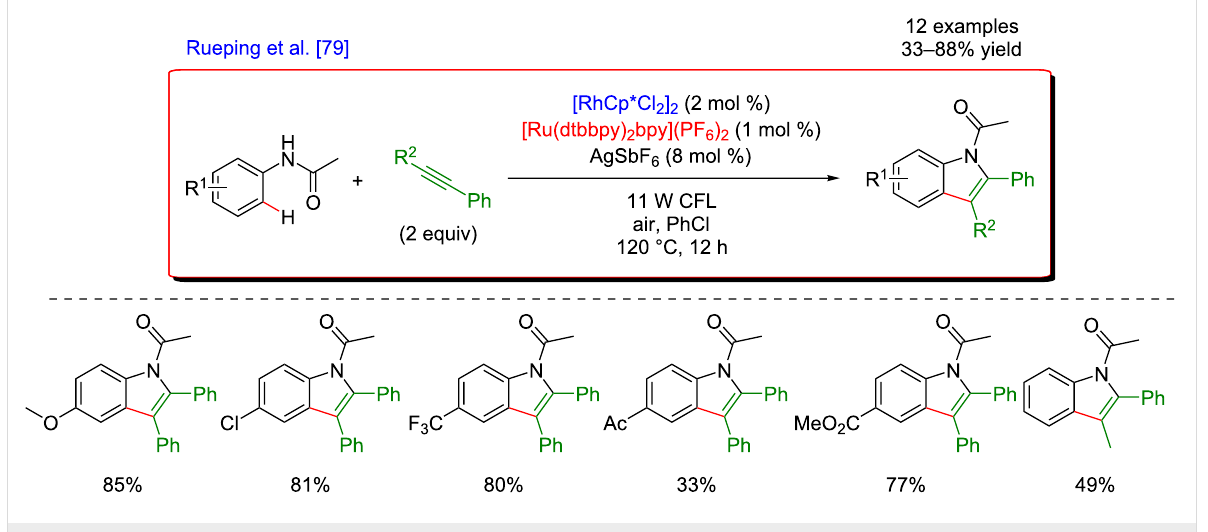
into the Co–C bond delivers a seven-membered cobaltacycle. The desired coupling product is then liberated by reductive elimination, producing a Co(I) species. Finally, the photoexci- ted eosin Y reoxidizes Co(I) to Co(II), while the photosensi- tizer is reoxidized by molecular oxygen, thus completing the overall catalytic